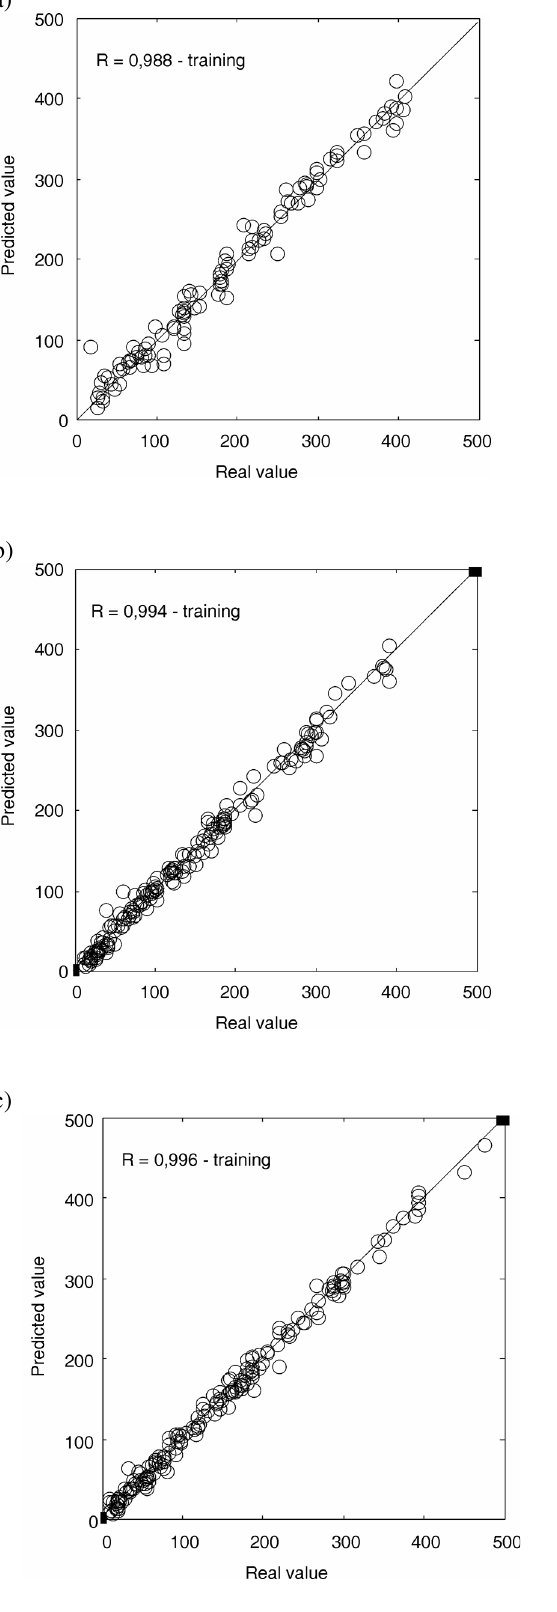
Figs 6 . Relation between value yielded by model simulating operation of machinery system and value predicted by neural network (for training and testing sets) for productivity W (N),S and hauling distance of a) 2 km, b) 5 km, c) 7